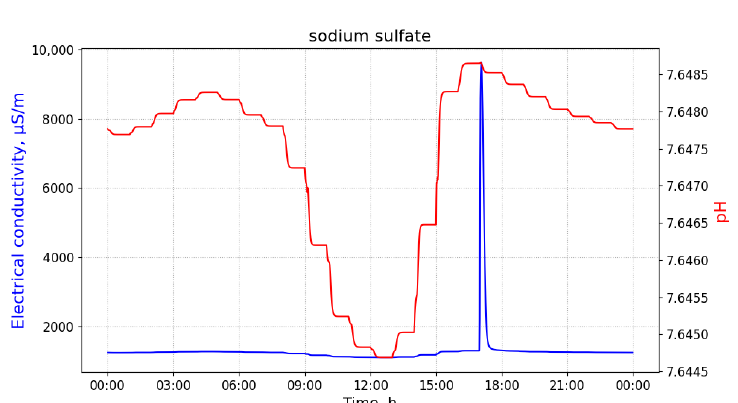
Figure 6. The measurements of pH and electrical conductivity for the utility network content contaminated with sodium sulfate. Values of the horizontal axis represent time of the day. Measured at the manhole 02, discharged at the building B33 with 100 L of the pollutant at 8